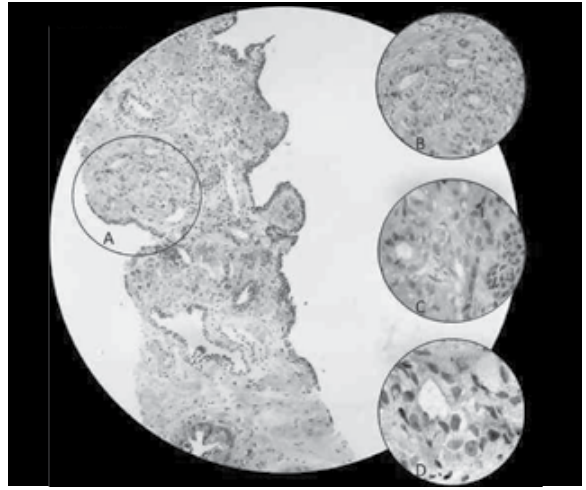
Figure 3 – ASAP (A) HE, 40×; (B) HE, 100×; (C) HE, 400×; (D) absence of basal cell layers,